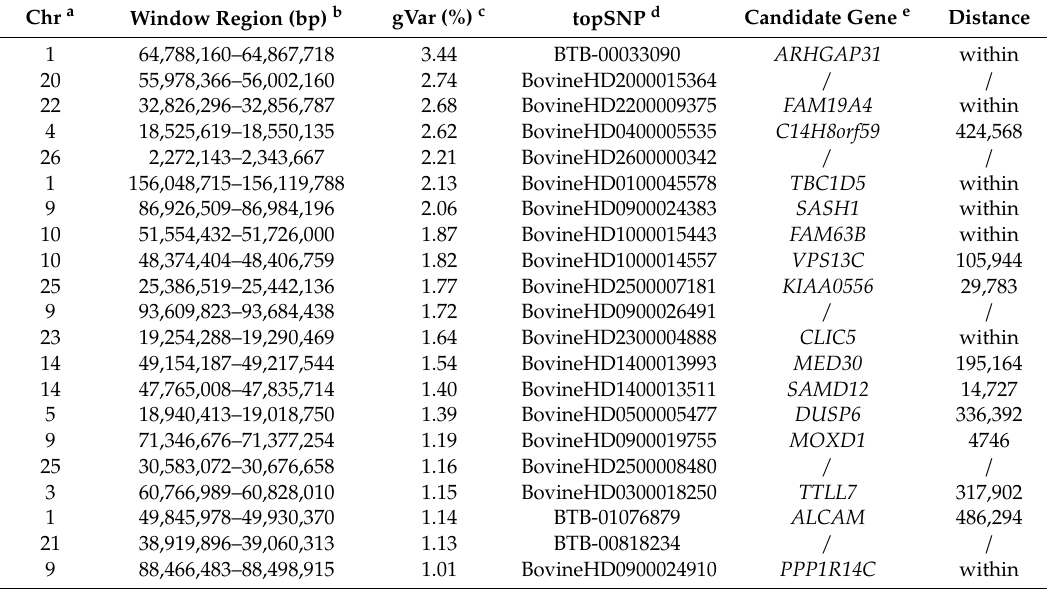
Table 5. Windows that explained > 1% of the additive genetic variance for 18-month weight in Simmental beef cattle.